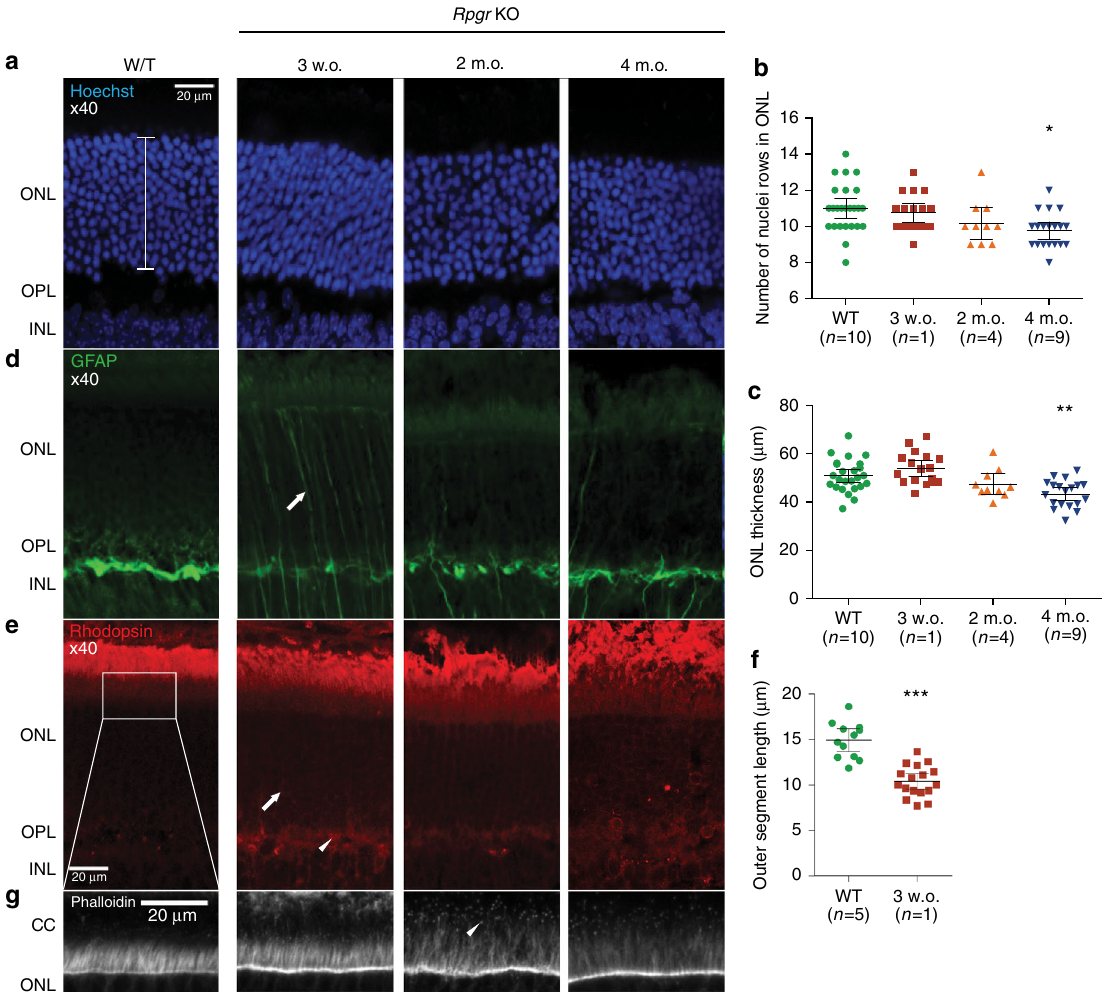
Fig. 3 The Rpgr KO mouse retina demonstrates actin dysregulation and rhodopsin mislocalisation in the photoreceptor layer prior to degeneration. a – c Outer nuclear layer (ONL — photoreceptor) degeneration develops in the Rpgr KO mouse ( bracket represents the region measured). This change is signi fi cant by 4 months of age (compared to 4-month old wild-type) as indicated by the number of rows of photoreceptor nuclei ( b ; Figures denote mean ± SEM, Kruskal – Wallis test [ H = 30.8, 4 d.f., p < 0.0001], Dunn ’ s multiple comparisons test, p < 0.05, * = p < 0.05) and ONL thickness ( c ; Figures denote mean ± SEM, one-way ANOVA [F(4,76) = 10.7, p < 0.0001], Tukey ’ s multiple comparisons test, p < 0.01 ** = p < 0.01). The WT control shown is 4 months of age. d , e Reactive gliosis as re fl ected by increased GFAP immunolabeling throughout the radial length of Müller cells in the ONL is apparent as early as 3 weeks of age (arrow; d ) while rhodopsin, normally only present in the outer segments outside (above in the fi gure) the ONL, is now mislocalised into other regions of the photoreceptor in the outer plexiform layer (OPL — arrowhead ; e ) and peri-nuclear area ( arrow ; e ) at this timepoint, prior to the visible onset of photoreceptor degeneration. f Outer segment length is reduced by 3 weeks of age (compared to 4-month old wild-type; Figures denote mean ± SEM, *** = p < 0.001) after which they become markedly disorganised. g Increased F-actin is seen in the connecting cilium ( arrowhead ) of the Rpgr KO mouse photoreceptor compared to wild type (Images representative of n = 1 – 10